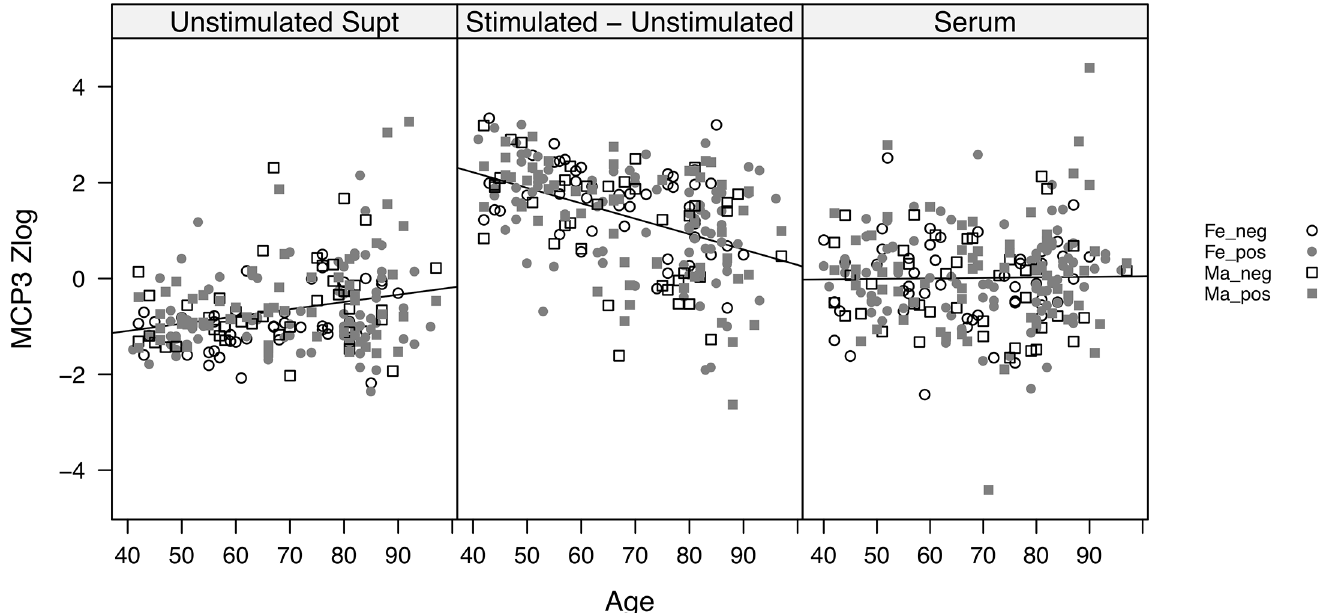
Fig 4. Example of a cytokine, MCP-3 (also known as CCL7) that shows differing trends with age depending upon the type of assay. Left panel, supernatant levels from unstimulated PBMC incubated for 4 hours. Middle panel, supernatant levels from PBMC stimulated with a cocktail of IFN α , LPS, CD3+CD28, and anti-IgM+IgG, after subtraction of unstimulated supernatant levels. Right panel, serum levels. All cytokines were measured by a 63-plex Luminex panel. Y-axis values represent the z score of median fluorescence intensity (MFI), after log2 transformation. Black line shows fitted regressions of analyte readout versus age. While CMV effects were not significant in any assay, age effects were significant for both unstimulated and stimulated- unstimulated supernatant assays.